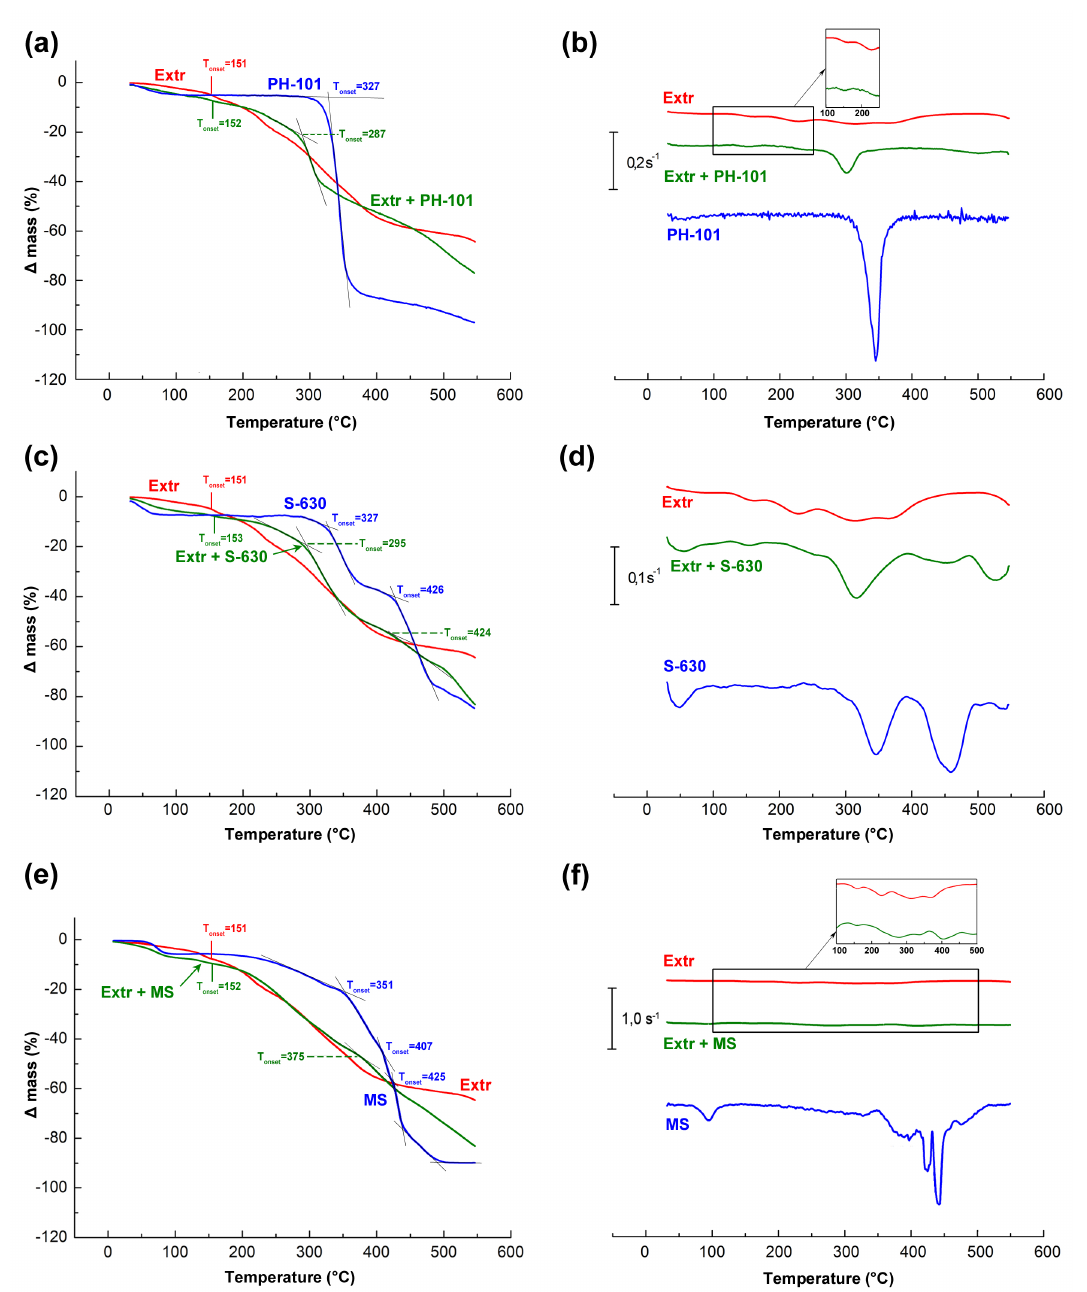
FIGURE 3 – TG and DTG curves of the bilberry leaf powder extract (Extr), the individual excipient and their binary mixture (1:1 mass ratio): Avicel PH-101 (PH-101) (a, b), Plasdone S-630 (S-630) (c, d), and magnesium stearate (MS) (e,